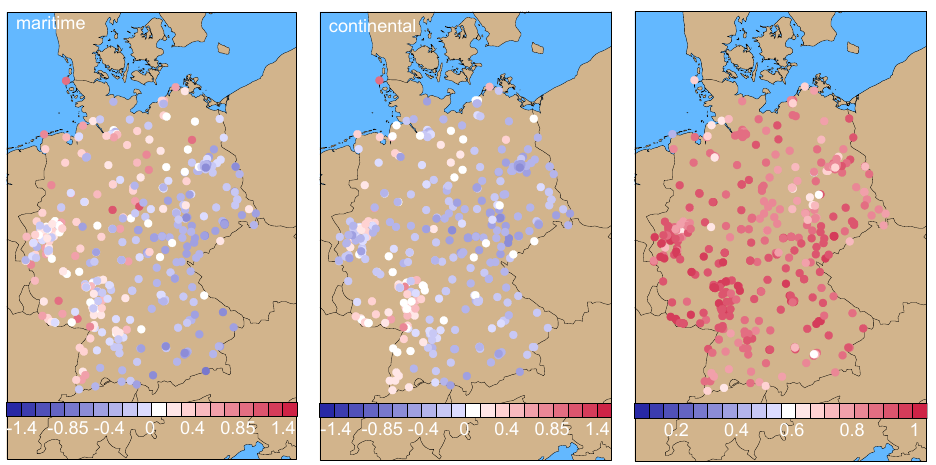
Figure 5. Comparison between modelled and measured daily PM 10 mass concentrations for the more maritime time period (24 March–31 March 2009) and the more continental time period (1 April–9 April 2009) in terms of the mean normalized bias (MNB) is shown. The right figure depicts the correlation coefficient. Measurements performed by the German Federal Environmental Agency